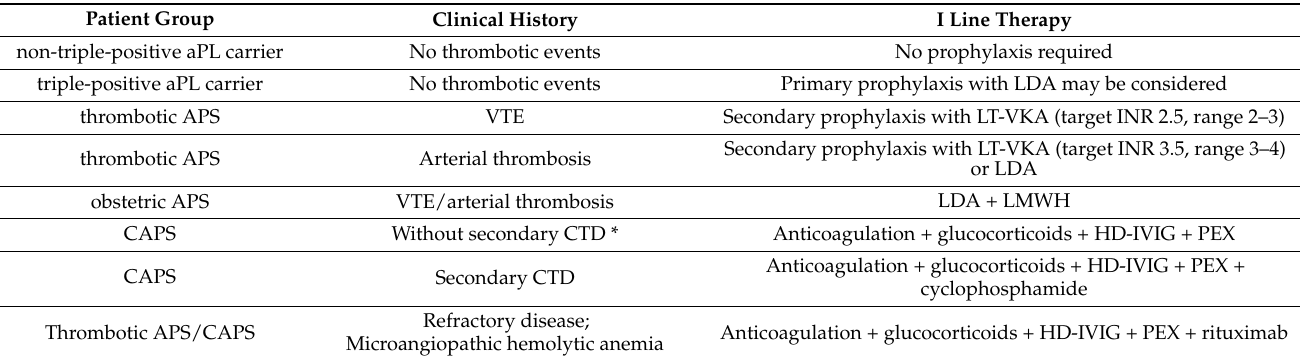
Figure 1. Algorithm for 1st and 2nd line treatment of SLE-associated thrombocytopenia. PDN: prednisone; MP: methylprednisolone; IVIG: intravenous immunoglobulins; HCQ: hydroxychloroquine; CS: corticosteroids; AZA: azathioprine; CSA: cyclosporine; CYC: cyclophosphamide; MMF: mycophenolate mofetil; d = days. Table 3. Potential treatments of APS with or without